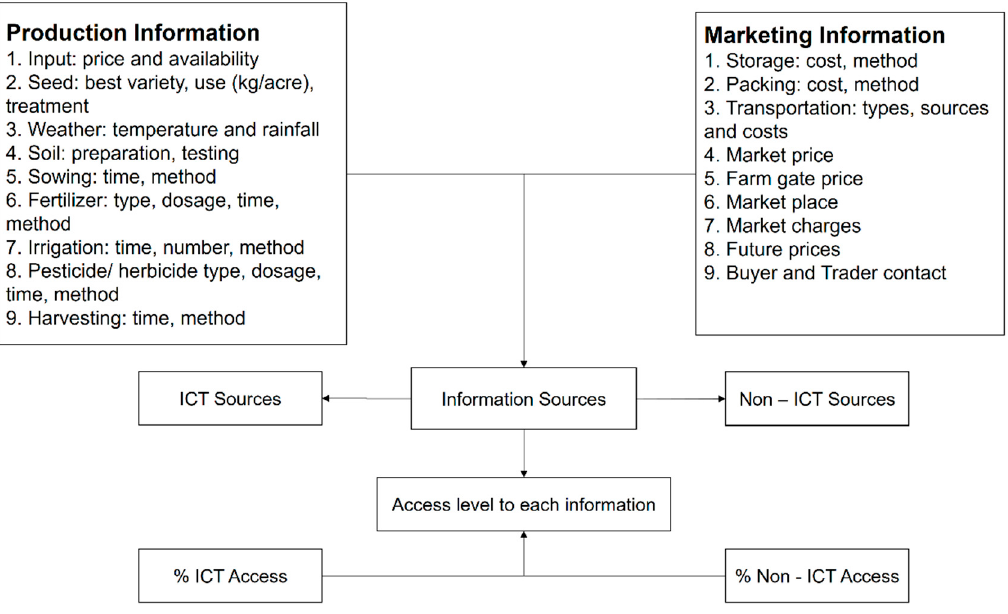
Figure 2. Conceptual framework.